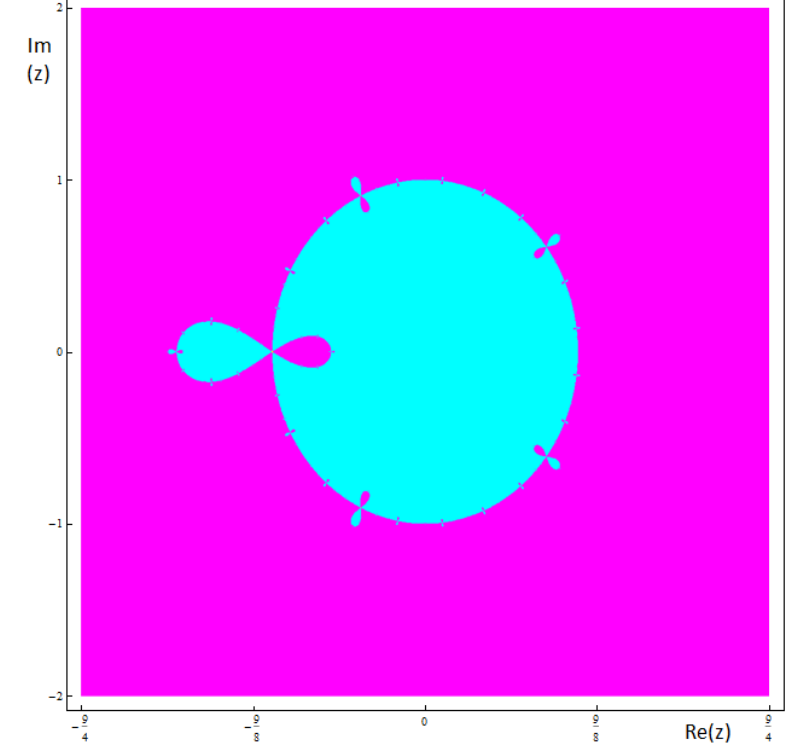
Figure 6. Basins of attraction associated to the member of the family a 0 = 1 and a 1 = − 3/4. This member has fifth order of